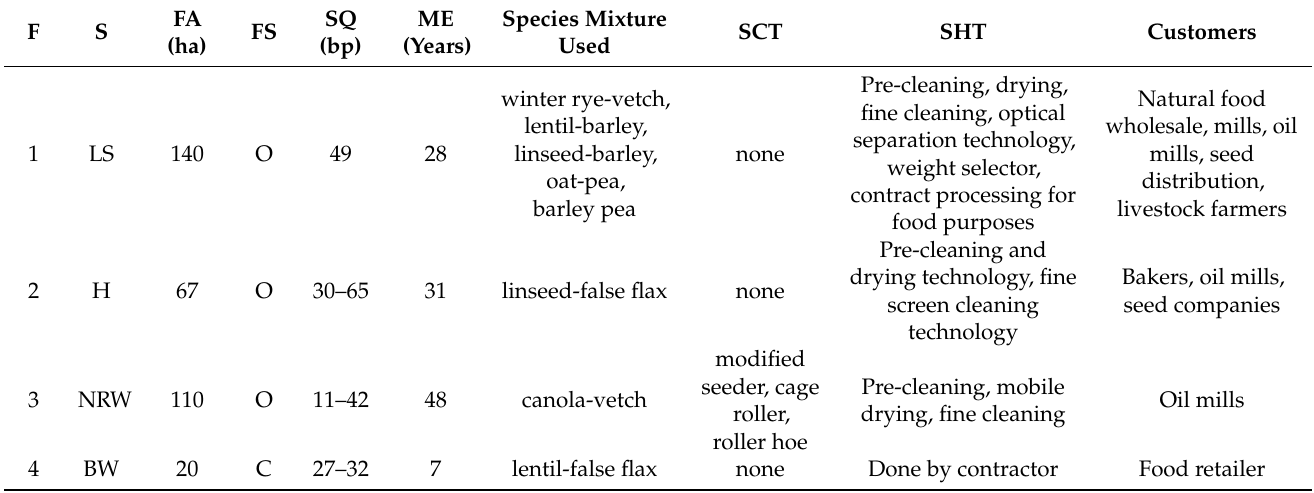
Table 1. Overview of the farms of the interviewees. F: farmer, S: federal state, FA: farming area, FS: farming system (O: organic, C: conventional), SQ: soil quality in bp based on the German soil classification system ranging from 1 to 100 bp, ME: mixture experience, SCT: specific